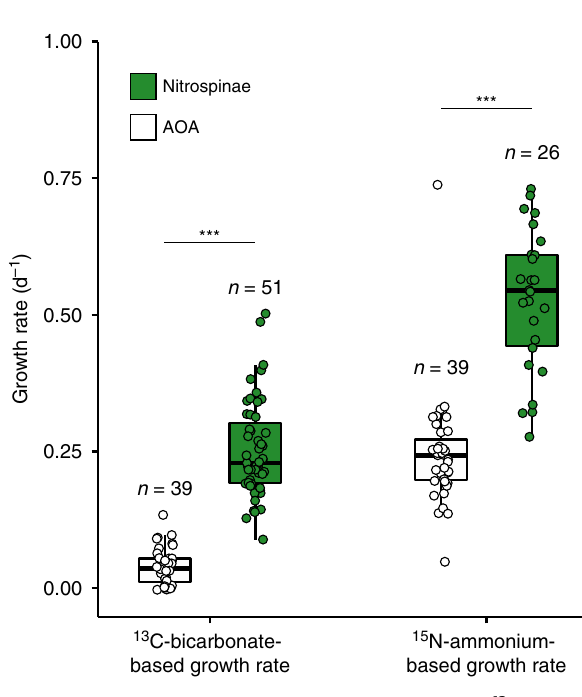
Fig. 4 Nitrospinae and AOA growth rates calculated from 13 C- bicarbonate and 15 N-ammonium assimilation measured by nanoSIMS. Nitrospinae 13 C-bicarbonate assimilation rates were determined from water samples after the addition of 15 N-ammonium and 13 C-bicarbonate, and 15 N- nitrite and 13 C-bicarbonate. AOA data were acquired from the incubation with added 15 N-ammonium and 13 C-bicarbonate only and were taken from Kitzinger et al. 31 . Number of cells analyzed per population is indicated above each boxplot. Boxplots depict the 25 – 75% quantile range, with the center line depicting the median (50% quantile); whiskers encompass data points within 1.5x the interquartile range. Data of each measured cell are shown as points; horizontal position was randomized for better visibility of individual data points. Nitrospinae had signi fi cantly higher growth rates than AOA, as indicated by stars (one-sided, two-sample Wilcoxon test, W = 1984, p = 4.04 × 10 − 16 for growth based on 13 C-bicarbonate assimilation and W = 1464, p = 3.32 × 10 − 12 for growth based on 15 N- ammonium